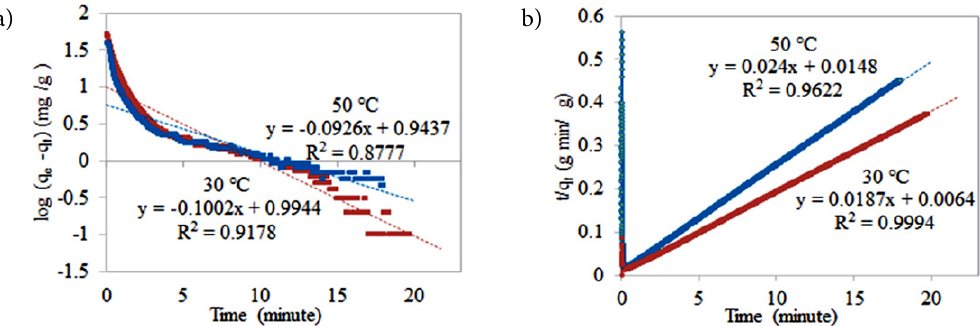
Figure 10. Kinetic plot a) pseudo-first-order kinetic model and b) pseudo-second-order kinetic model at different adsorption temperatures for CeO 2 /AC.